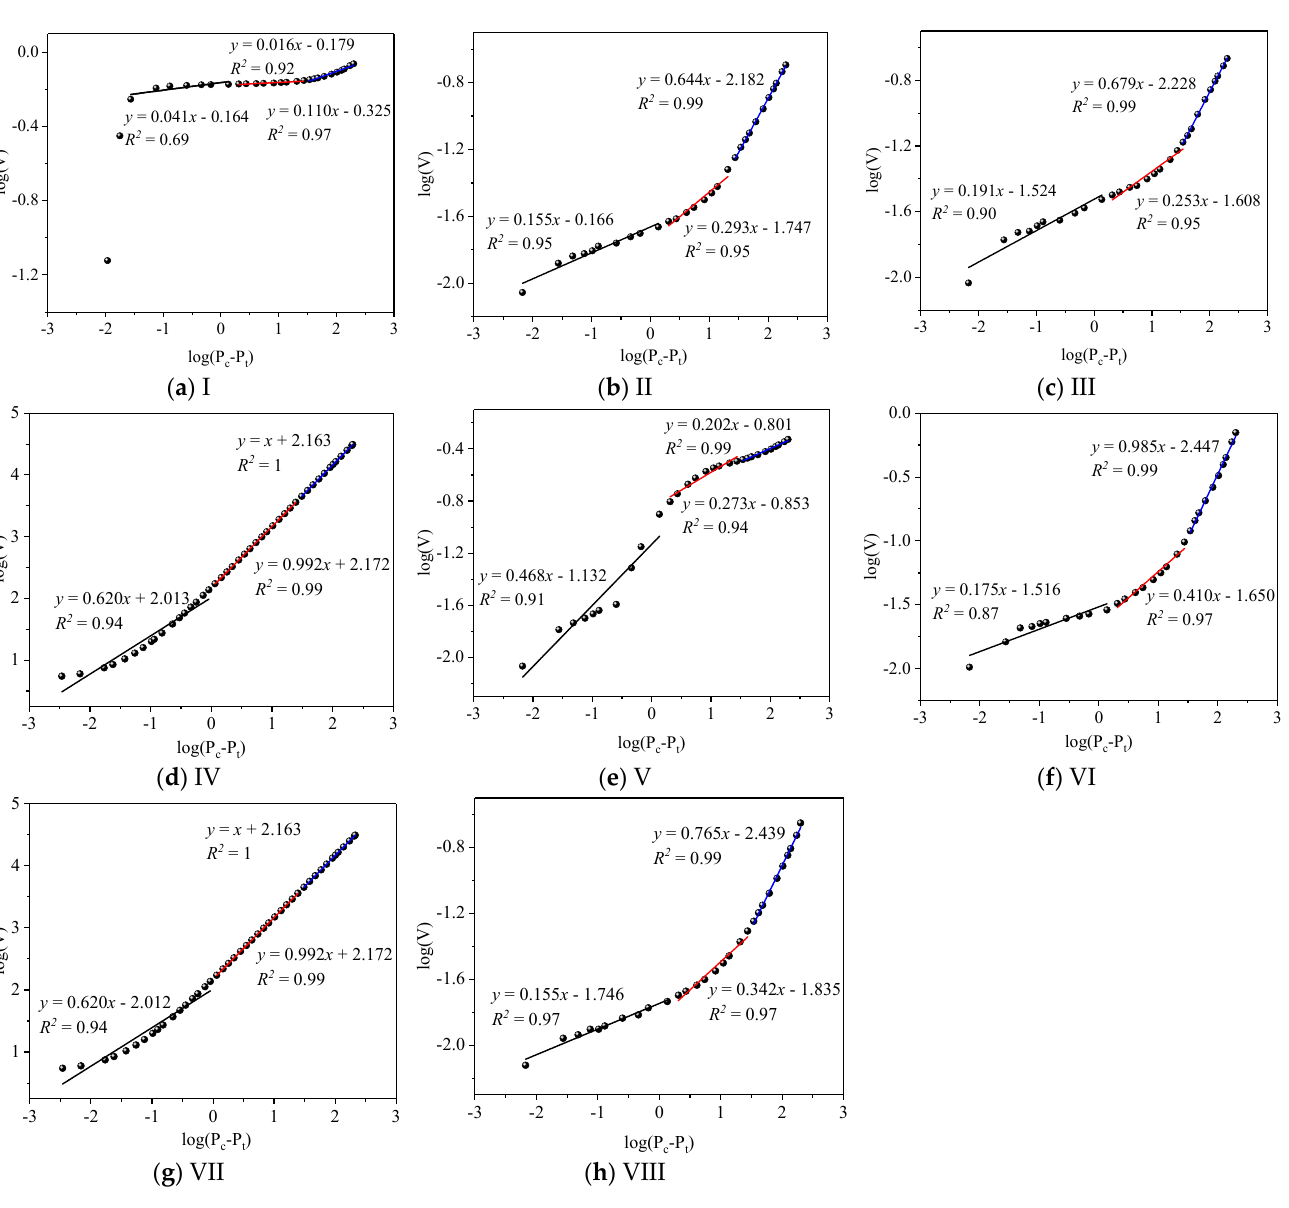
Figure 5. Fractal dimensions ( D 2 , D ′ 2 and D ″ 2 ) calculated from log(V) vs. log(p c − p t ) of MIP analysis: